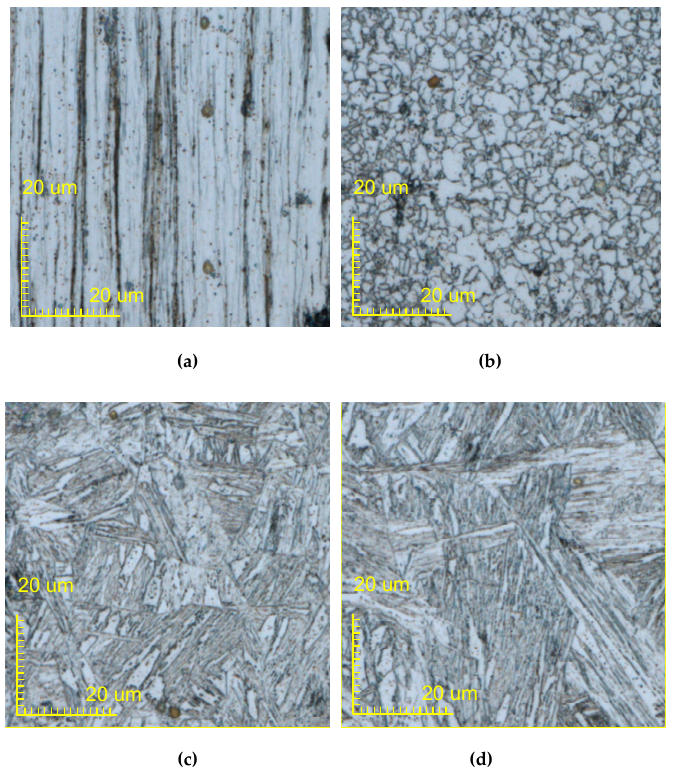
Figure 15. Micrograph of a single metal wire after melting and solidification. ( a ) The oxidation region, ( b ) the heat-a ff ected zone, ( c ) the semi-melted region, and ( d ) the melted region.